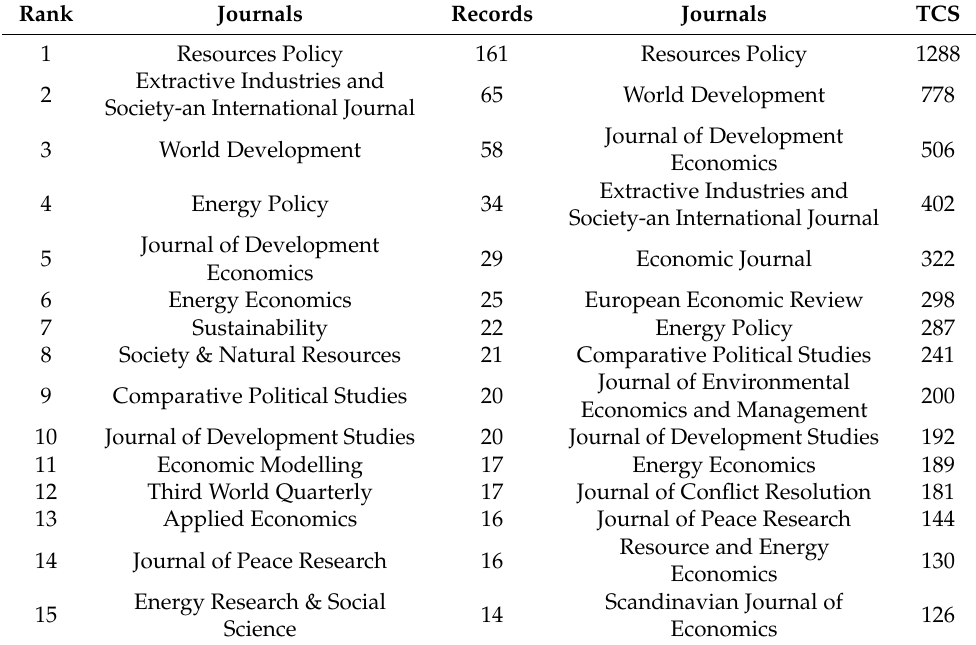
Table 4. Top 15 journals in terms of document number and total connection